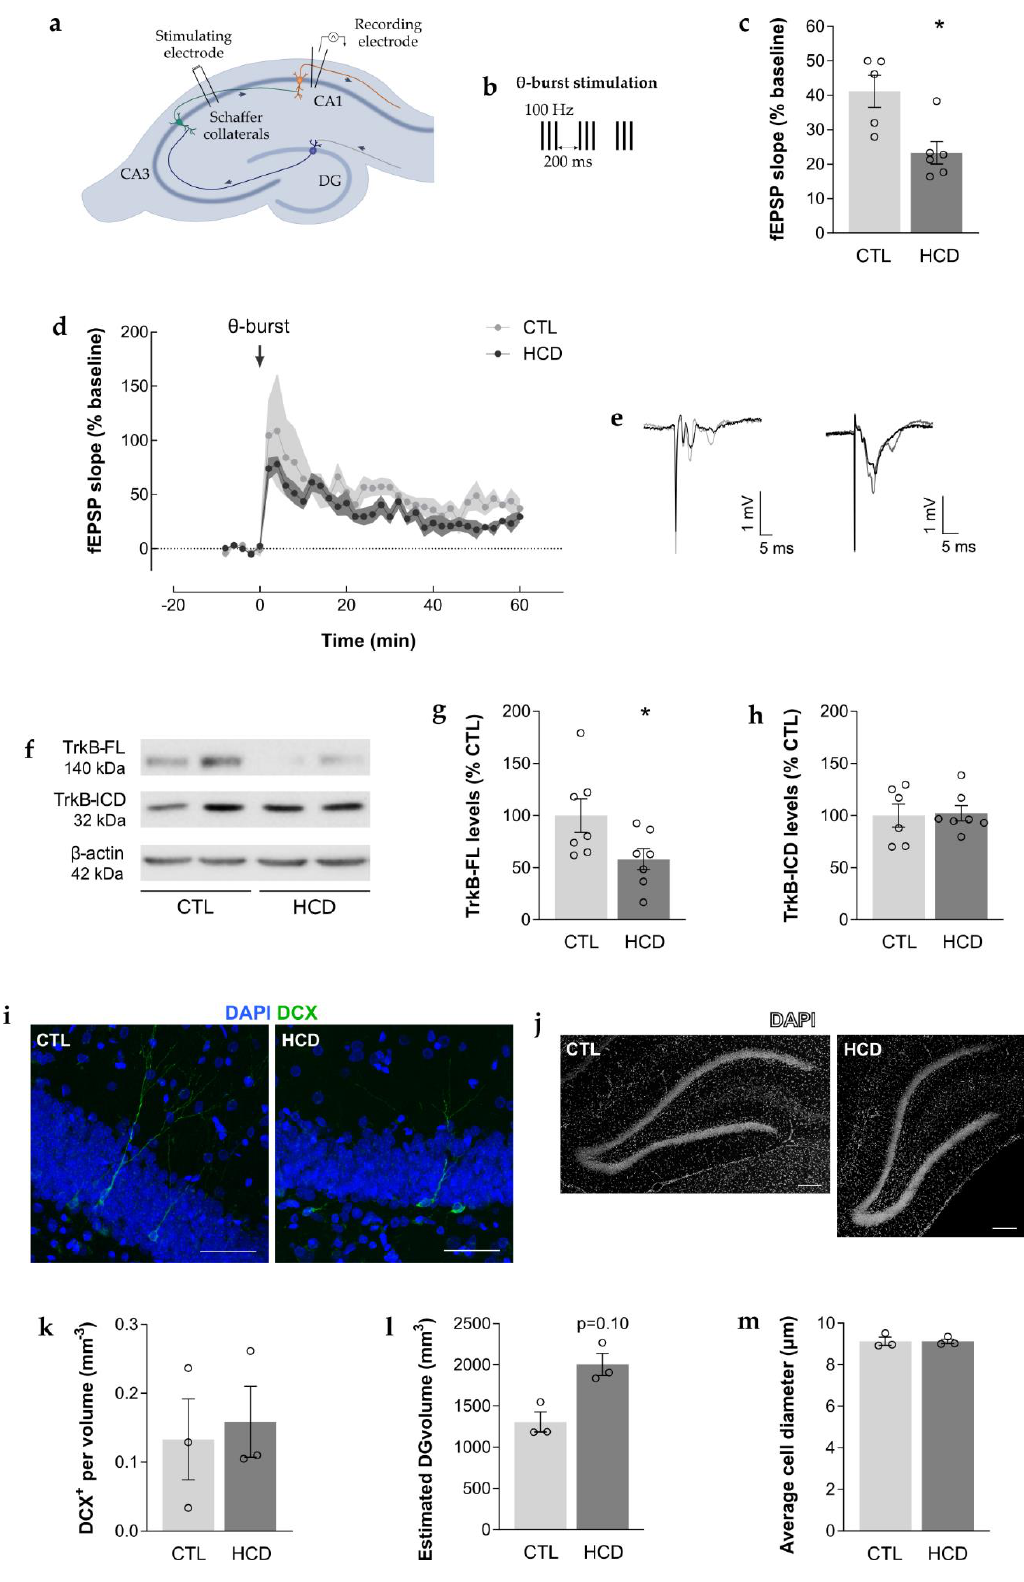
Figure 2. A chronic high caloric diet (HCD) promoted hippocampal synaptic plasticity impairment and reduced the levels of hippocampal TrkB-FL without impacting neurogenesis. ( a , b ) Representative scheme of electrophysiological recordings